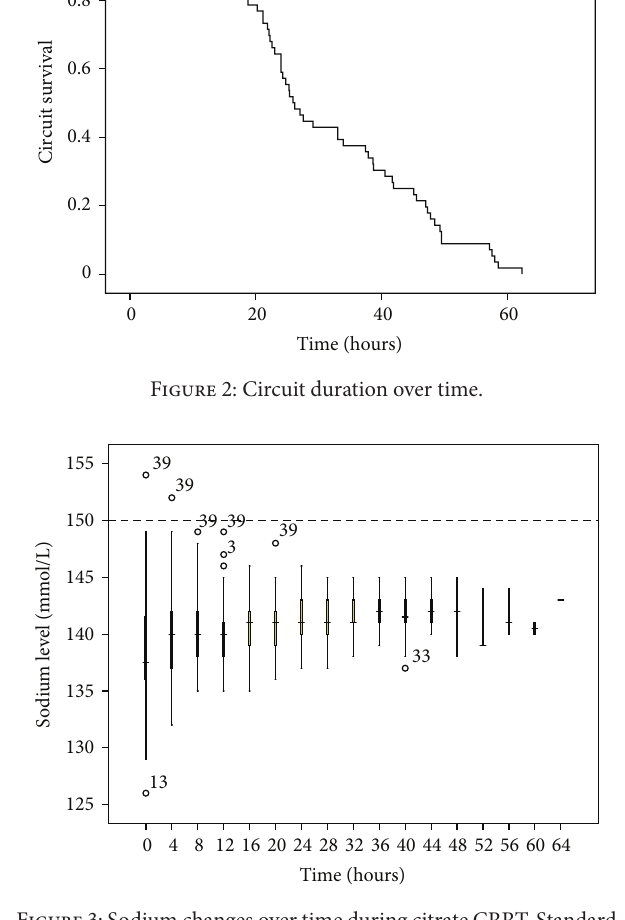
Figure 3: Sodium changes over time during citrate CRRT. Standard boxplotinwhichthehorizontallinerepresentsthemedian,thethick line represents the interquartile range, and the thin line represents the maximum and minimum values. The circular dots represent the outliers.